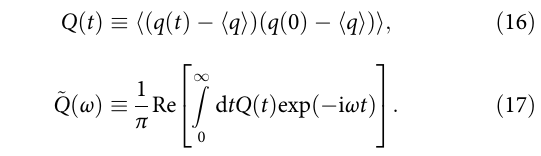
Figure 3a, c plot the measured spectral density of fl